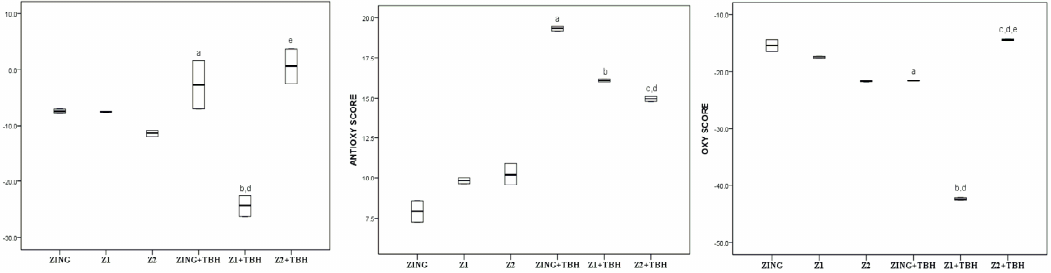
Figure 3. Values of pro-oxidative, antioxidative and oxidative scores of zingerone (ZING) and its two derivatives (Z1, Z2) in serum pool before and after the addition of TBH; Values are represented by median (horizontal line) and interquartile range (25–75th percentile (lower and upper edge, respectively)). a,b,c,d,e—significant difference ( p < 0.05) compared to ZING, Z1, Z2, ZING + TBH, Z1 + TBH respectively.